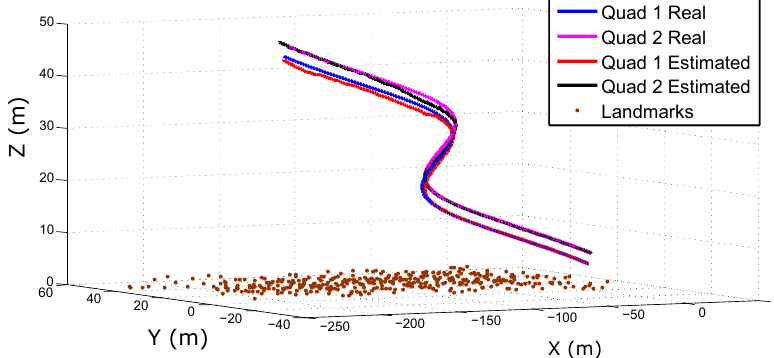
Figure 6. Estimated trajectories of the Quadcopters (Quad) obtained with the cooperative method.